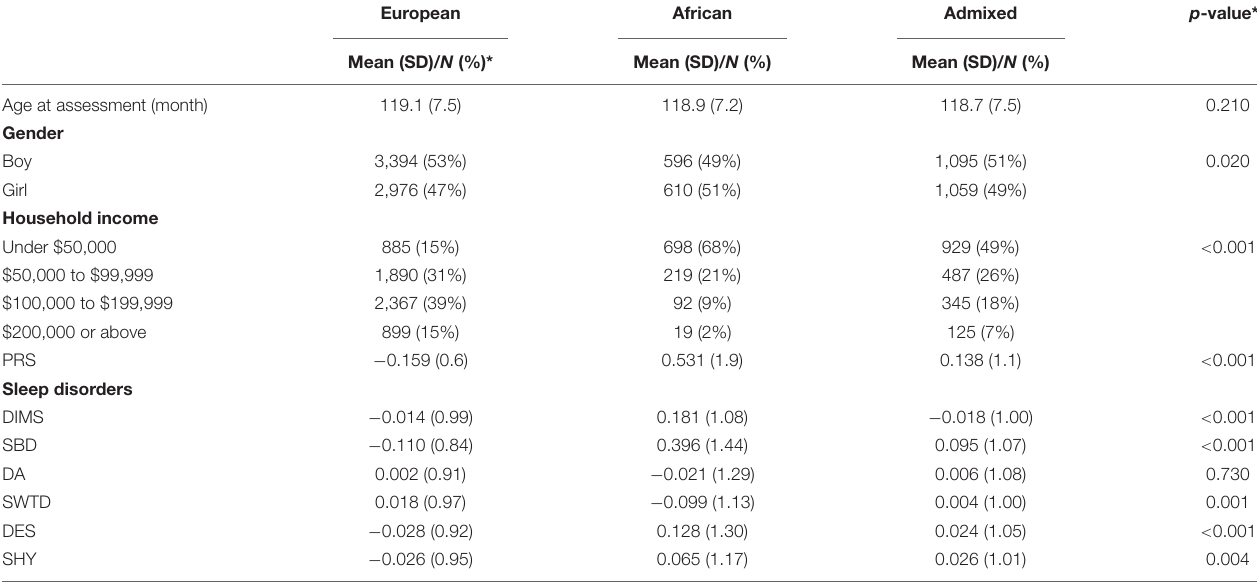
TABLE 1 | Participants characteristics, PRS, and SDSC subscales by